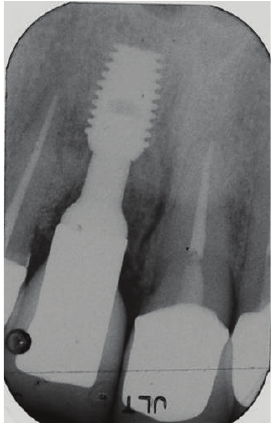
Figure 30: The radiograph performed after five years shows full integration of the implant and good stability of interproximal soft tissues, along with almost full filling of the lateral incisor’s periodontal